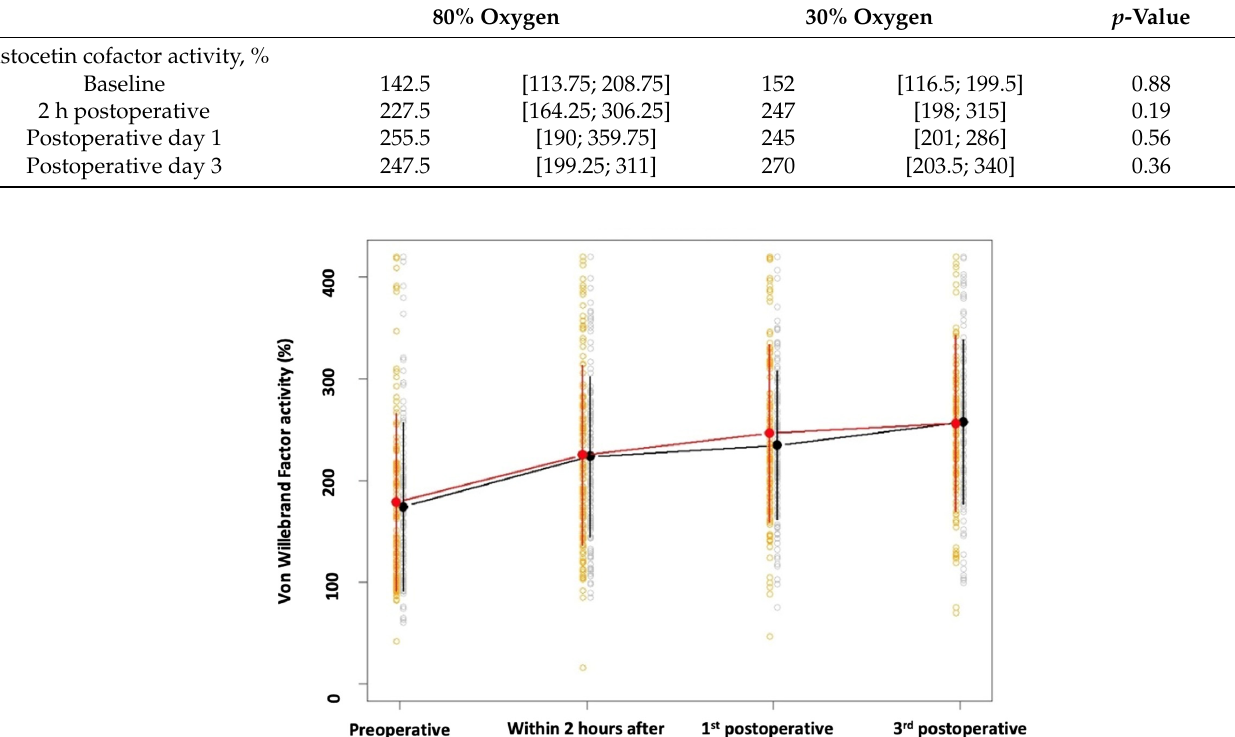
Table 1. Descriptive statistics for vWF activity and Ristocetin cofactor activity. VWF activity and Ristocetin cofactor activity at each timepoint are presented as median (25th quartile; 75th quartile). All p -values are for two-tailed Mann–Whitney U tests.